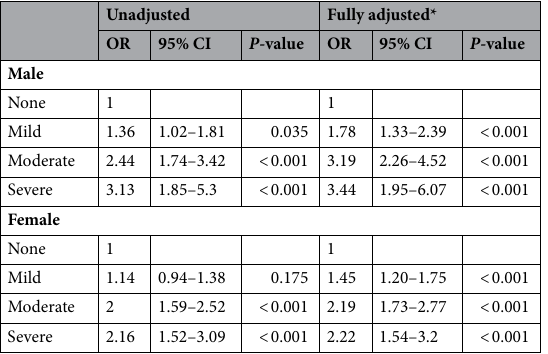
Table 3. Sex-stratified logistic regression analysis. CI confidence interval, LBP low back pain, OR odds ratio. *Fully adjusted for age, and other environmental factors, such as obesity, sleep duration, smoking, alcohol consumption, education level, household income, occupation, physical activity, and comorbidities. P < 0.05 was taken to indicate statistical